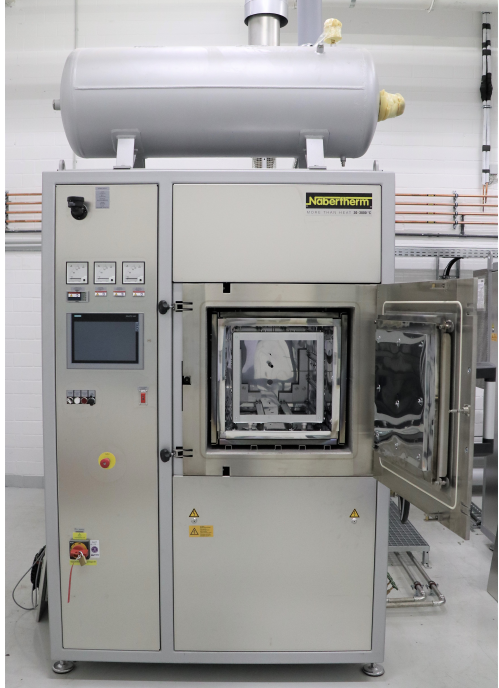
Figure 3. Nabertherm VHT40/16 cold wall retort furnace used to sinter the parts presented in this study.